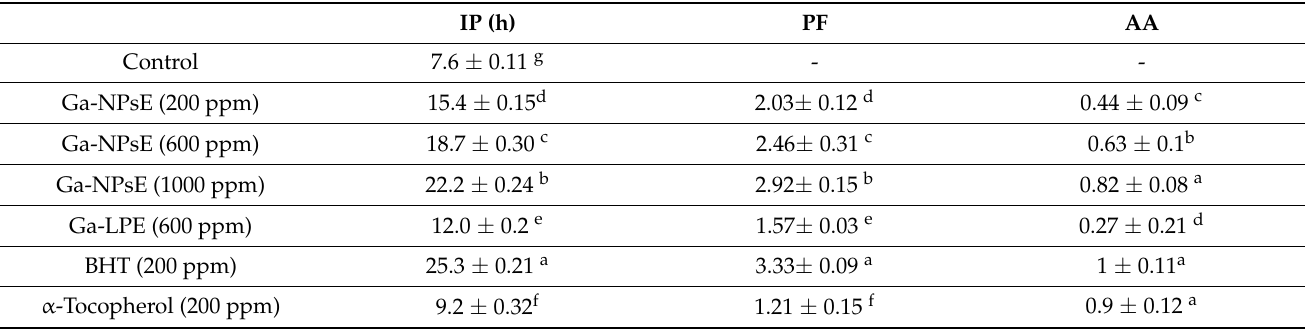
Table 5. Induction period (IP), protection factor (PF), and antioxidant activity (AA) of garlic nanopar- ticle extracts during storage at 65 ◦ C (mean ± SD, n = 3).